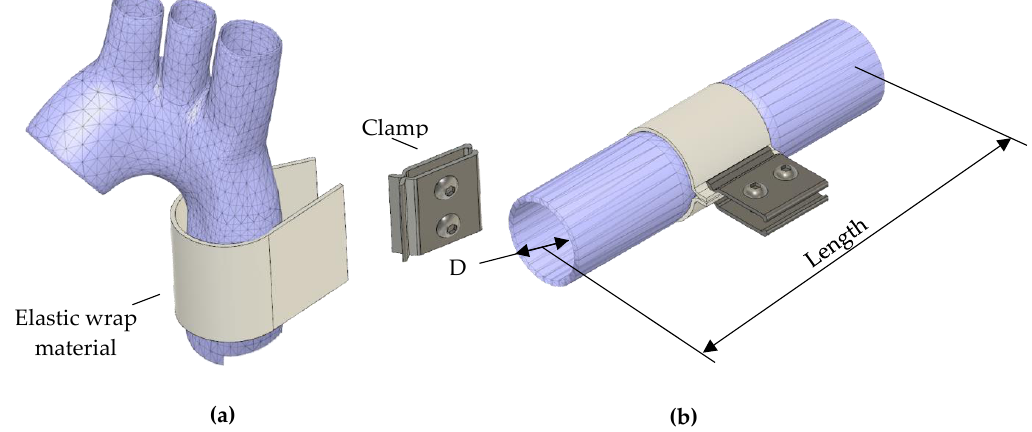
Figure 1. ( a ) Schematic representation of elastic aortic wrapping procedure on an idealised aorta, reproduced from [3]; and ( b ) the dimensions of the model aorta geometry (shortened for the purpose of illustration).